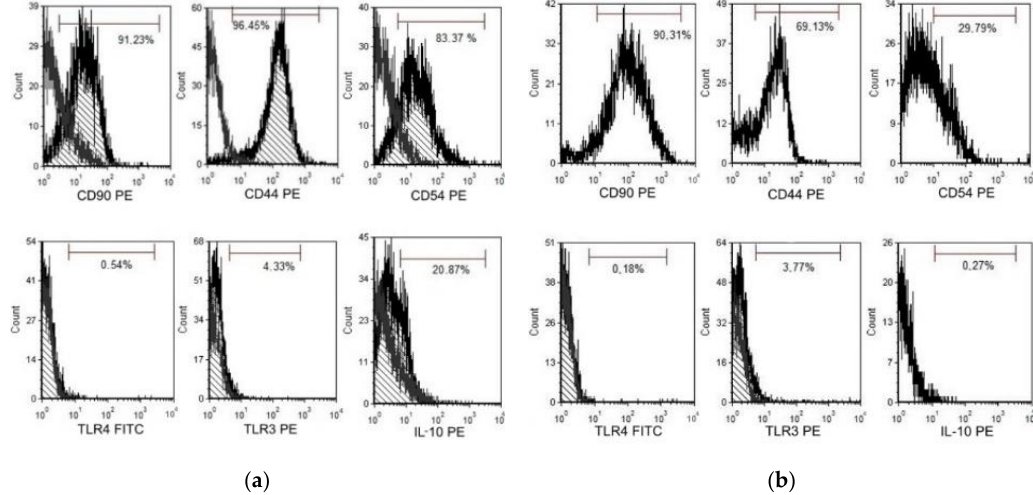
Figure 8. ( a ) Flow cytometry (FACS) analysis chorionic mesenchymal stem cells activated with polyinosine: polycytidylic acid CMSCs Poly (I:C) co-culture with lymphocyte and ( b ) FACS analysis CMSCs non-activated CMSCs co-culture with lymphocyte. Representative flow cytometry analysis.